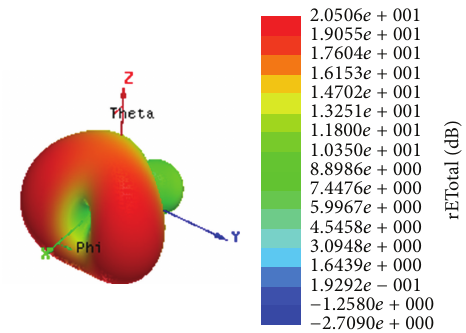
Figure 10: Simulated 3D radiation pattern plot for 12